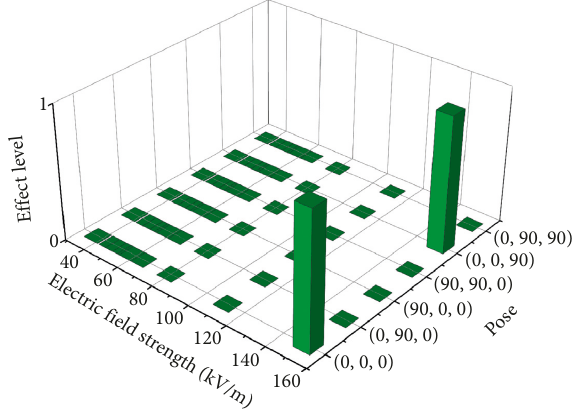
Figure 19: Effect level of the